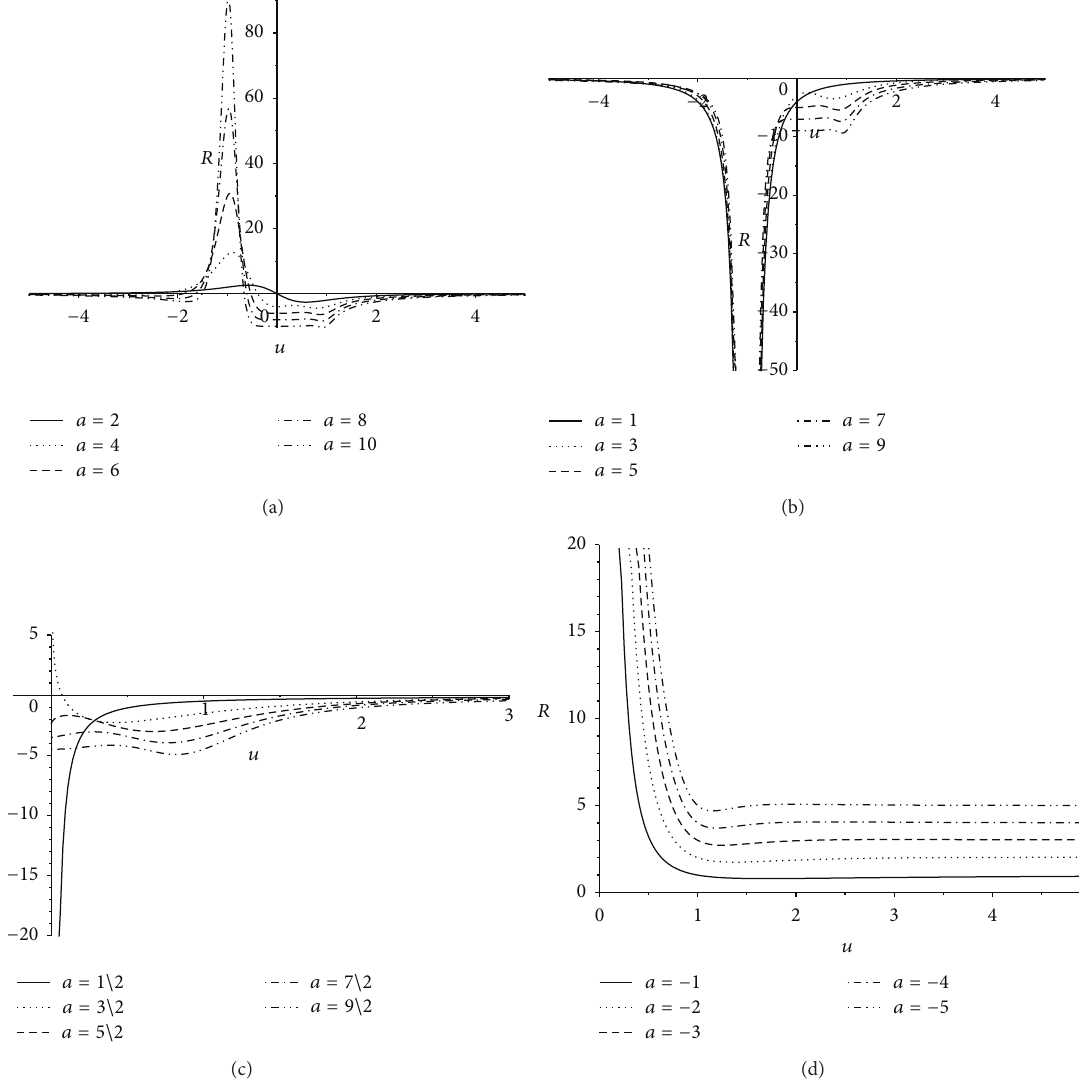
Figure 1: The three qualitatively different types of radial functions. The horizontal axis corresponds to the energy, while the vertical represents the radius of the circumference. We observe that only the curves corresponding to negative values of the exponent 𝛼 are positive definite in the full physical domain, that is, positive values of energy and